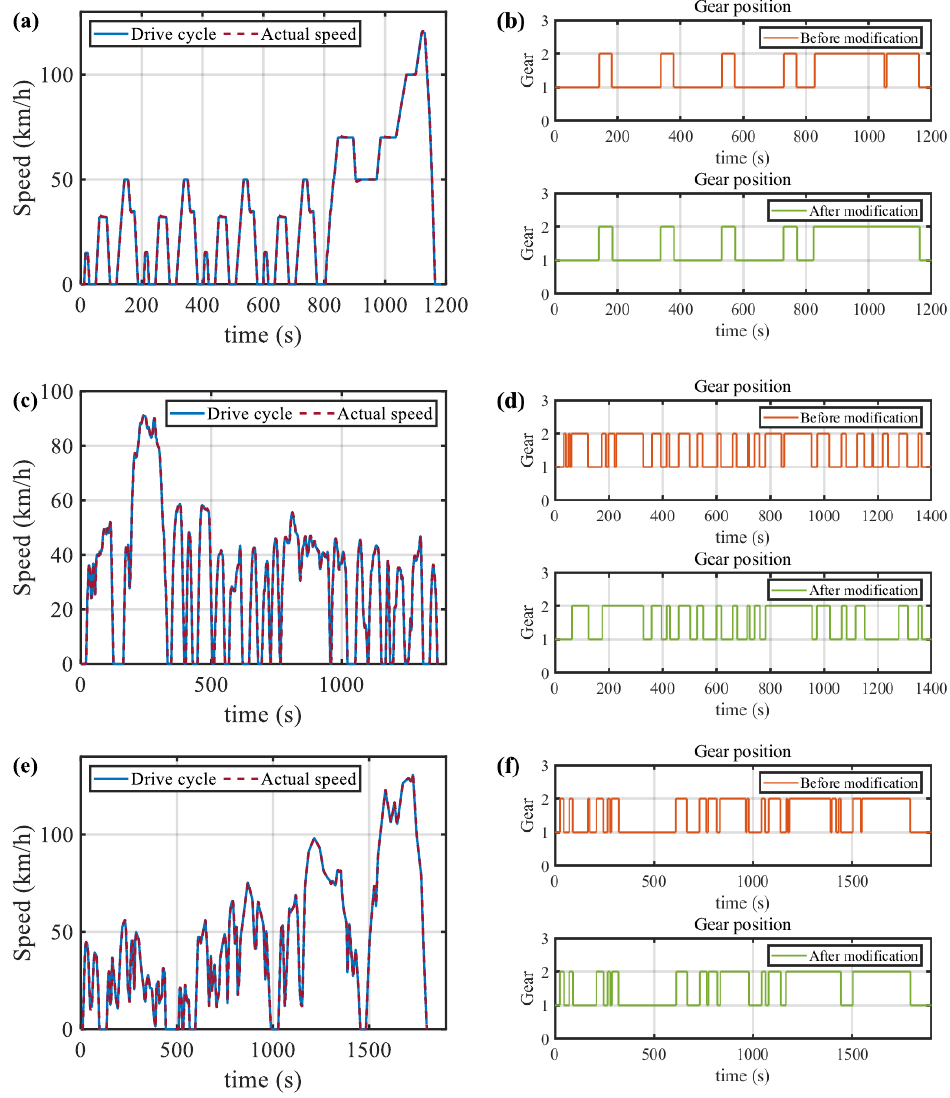
Figure 13. Vehicle speed tracking and gearshifts trajectories: (a) NEDC driving cycle; (b) Gear position;(c) UDDS driving cycle;(d) Gear position;(e) WLTC driving cycle;(f) Gear position.